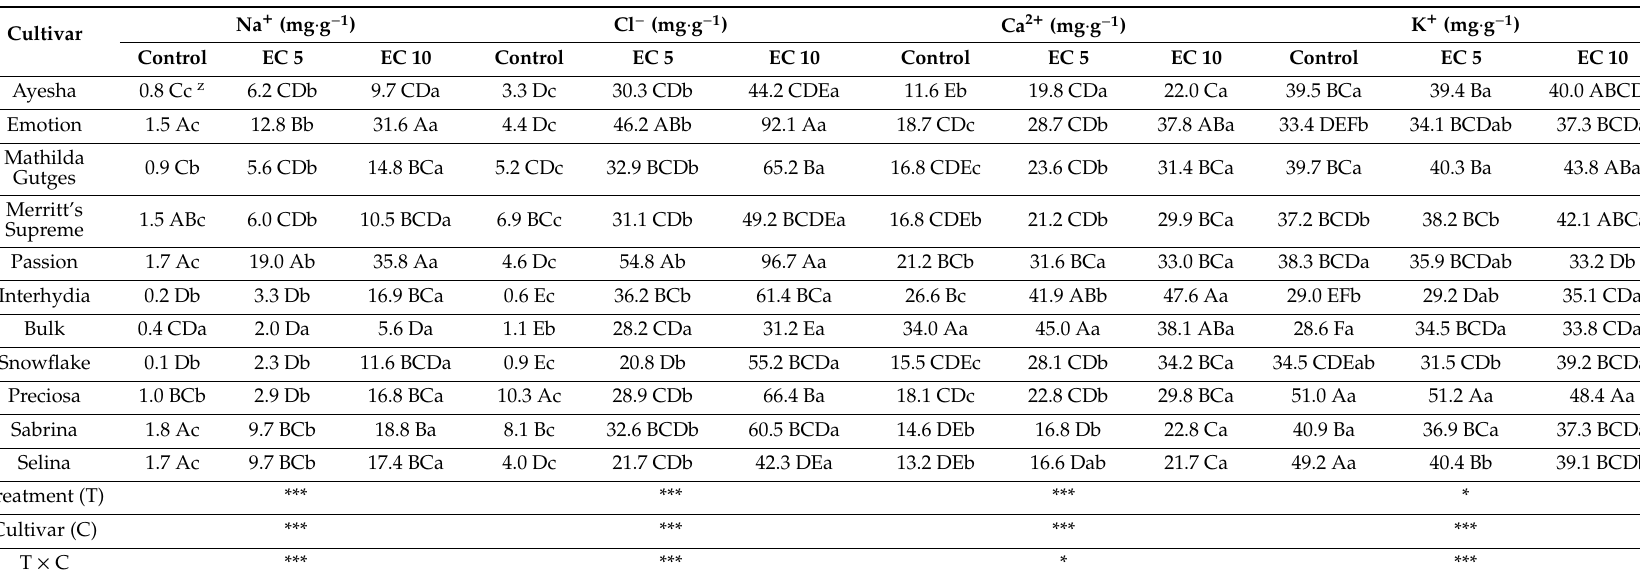
Table 3. Mean leaf sodium (Na + ), chloride (Cl − ), calcium (Ca 2 + ) and potassium (K + ) concentrations of 11 hydrangea cultivars irrigated with a nutrient solution (electrical conductivity (EC) = 1.0 dS · m − 1 ; control) or a saline solution (EC = 5.0 dS · m − 1 (EC 5) or 10.0 dS · m − 1 (EC 10)) in Experiment 1. Significance of main e ff ects and interactions denoted by ***, ** and * ( p < 0.001, p < 0.01 and p < 0.05, respectively).